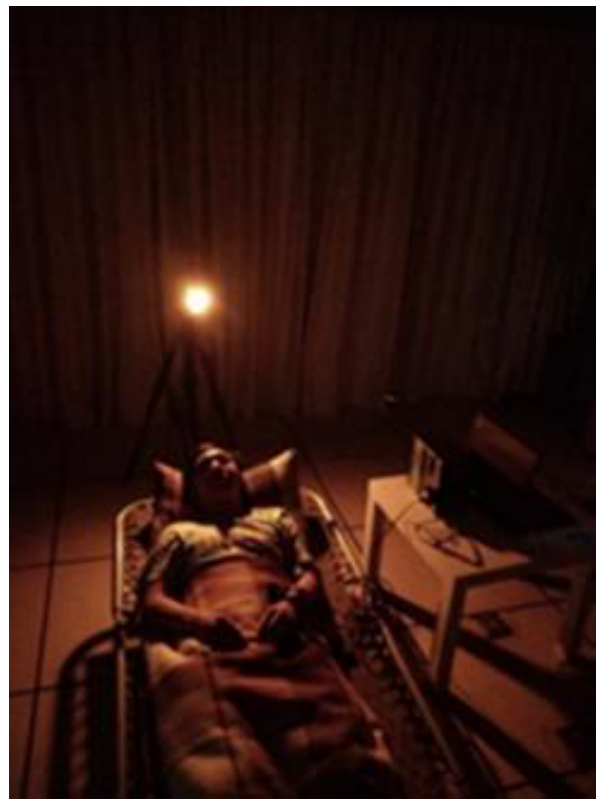
Figure 6. Execution of sleep experiments.